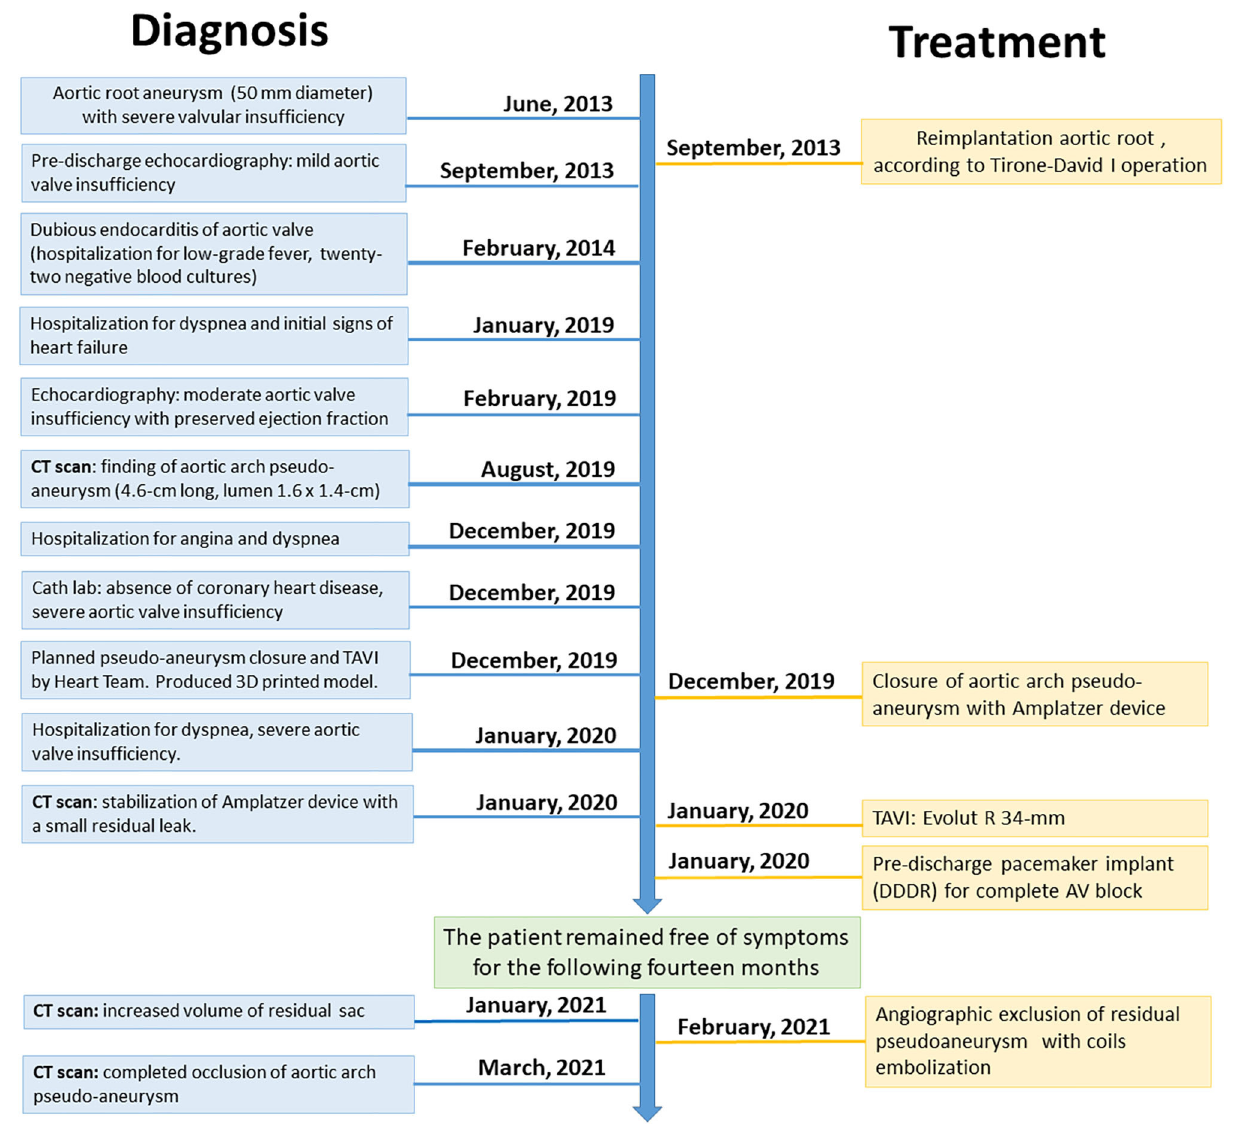
FIGURE 1 | Timeline of the reported clinical